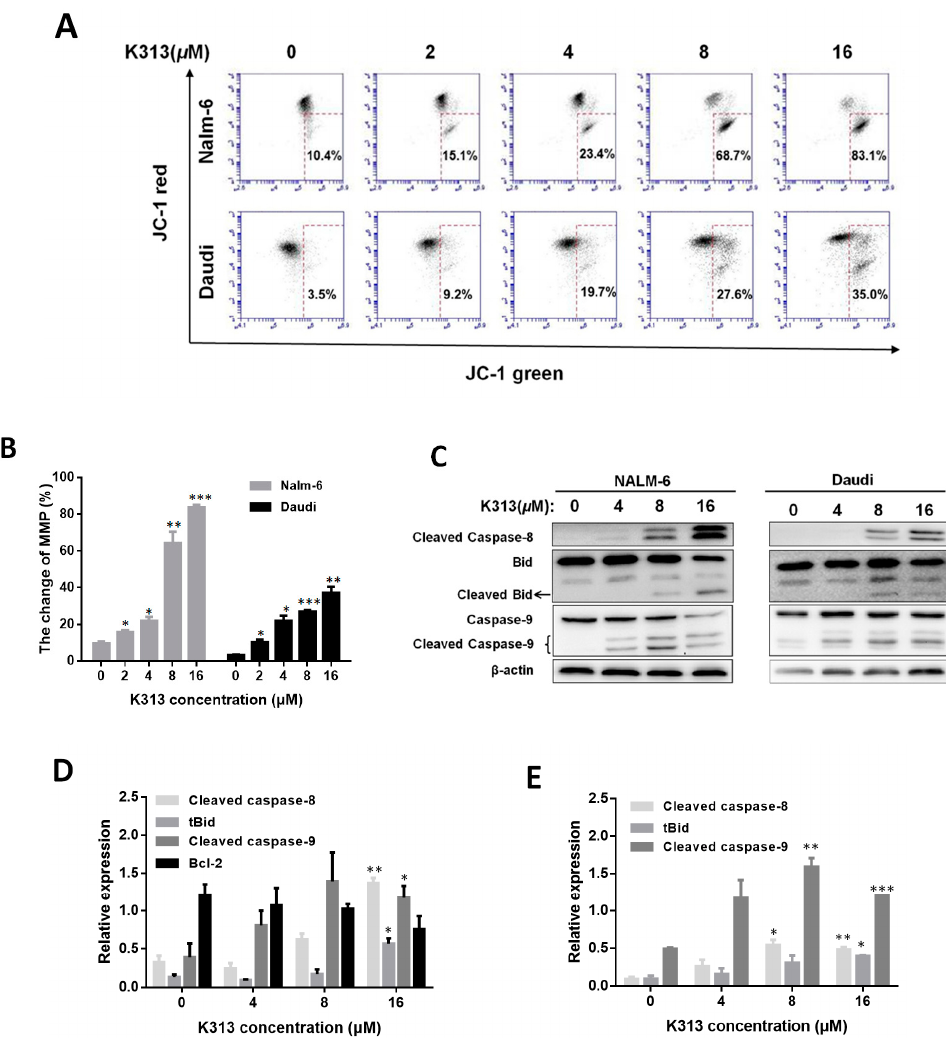
Figure 4. K313 induces apoptosis in Nalm-6 and Daudi cells through the mitochondrial pathway. ( A ) Nalm-6 and Daudi cells were treated with K313 at indicated concentrations for 48 h and stained with JC-1 for 15 min. Loss of mitochondrial membrane potential was measured by FCM. ( B ) Columns represent the percentage of change of the MMP in Nalm-6 and Daudi cells. ( C ) After treatment with the vehicle or K313 for 24 h, the total protein lysates were detected by immunoblotting with antibodies. The expression levels of apotosis-related proteins in ( D ) Nalm-6 and ( E ) Daudi cells were quantified by Quantity One software. * p < 0.05, ** p < 0.01, and *** p < 0.001 vs. control group.